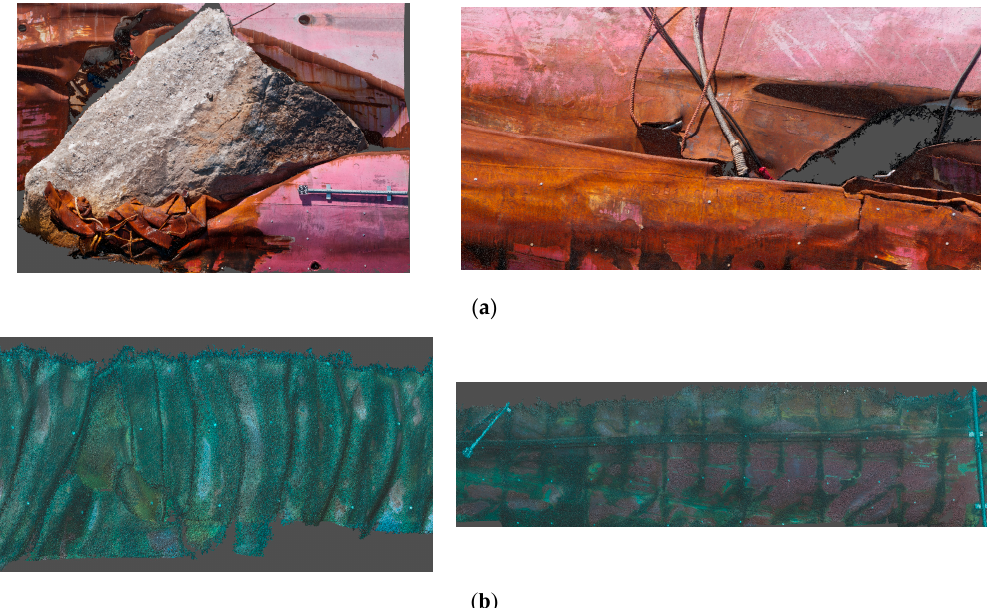
Figure 11. Details of dense point clouds from dense image matching process for the above ( a ) and underwater models ( b ). underwater models ( b